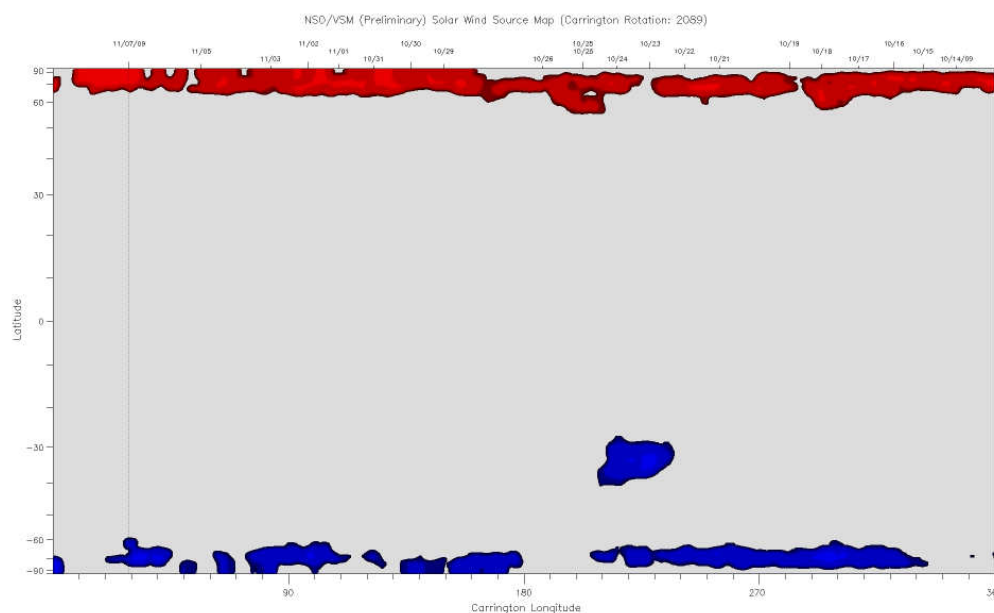
Fig. 7. A midlatitude coronal hole during 2009. Also present are polar coronal holes at both polar regions.